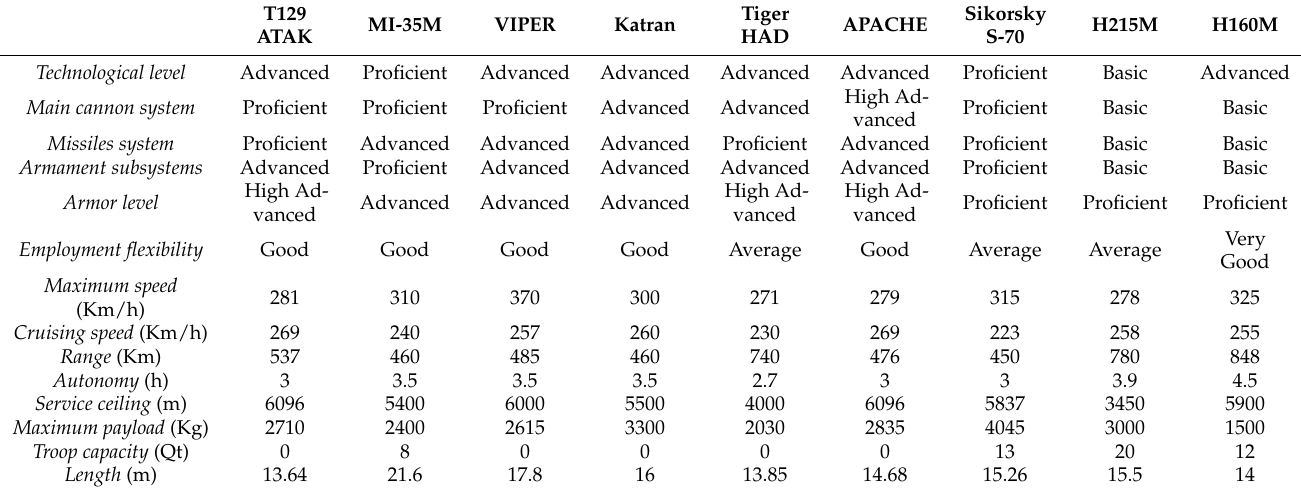
Table 4. Evaluation matrix regarding the helicopters under qualitative and quantitative criteria. T129 MI-35M VIPER Katran ATAK